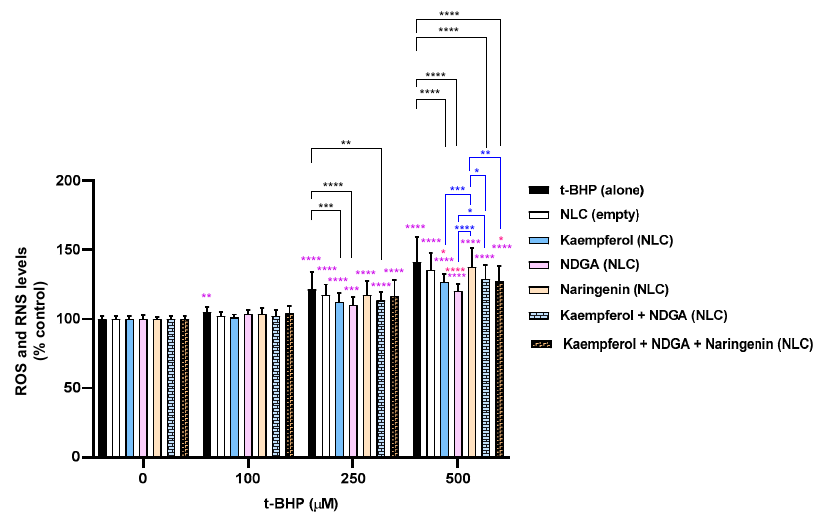
Figure 5. Intracellular levels of ROS/RNS 6 h after exposure to t-BHP (0–500 μ M) in the presence or absence of the developed NLC formulations. Results are expressed as mean ± SD from six independ- ent experiments performed in triplicate. Statistical comparisons were made using two-way ANOVA followed by the Tukey’s multiple comparisons test (* p < 0.05, ** p < 0.01, *** p < 0.001; **** p < 0.0001; in purple the statistical analysis for each condition versus 0 μ M t-BHP is represented; in red the statistical analysis at each t-BHP concentration for the comparison between NC-loaded NLC formu- lations and the unloaded NLC formulation is presented; in black the statistical analysis at each t- BHP concentration for the comparison between each NLC formulation and t-BHP alone is represented; in blue the statistical analysis at each t-BHP concentration for the comparison between the different NC-loaded NLC formulations is represented). In all cases, p -values < 0.05 were considered